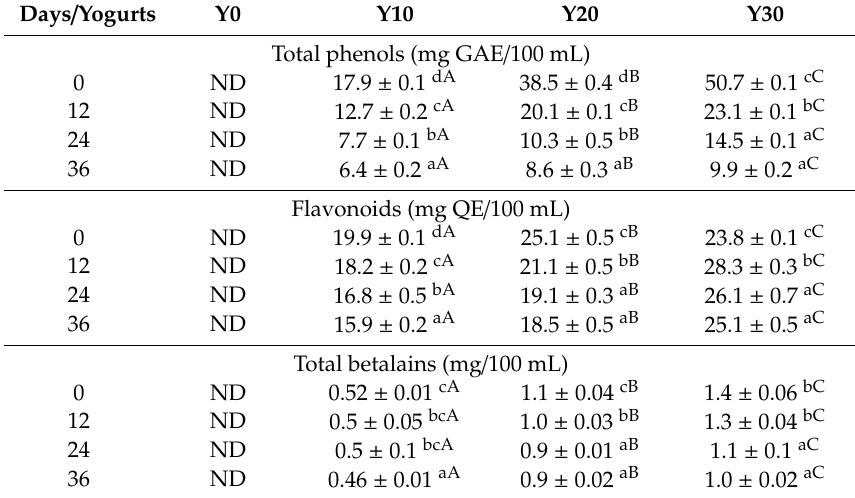
Table 2. Total phenols, flavonoids and total betalains in di ff erent yogurts added with di ff erent % ( w / w ) of multiple emulsions during 36 days of